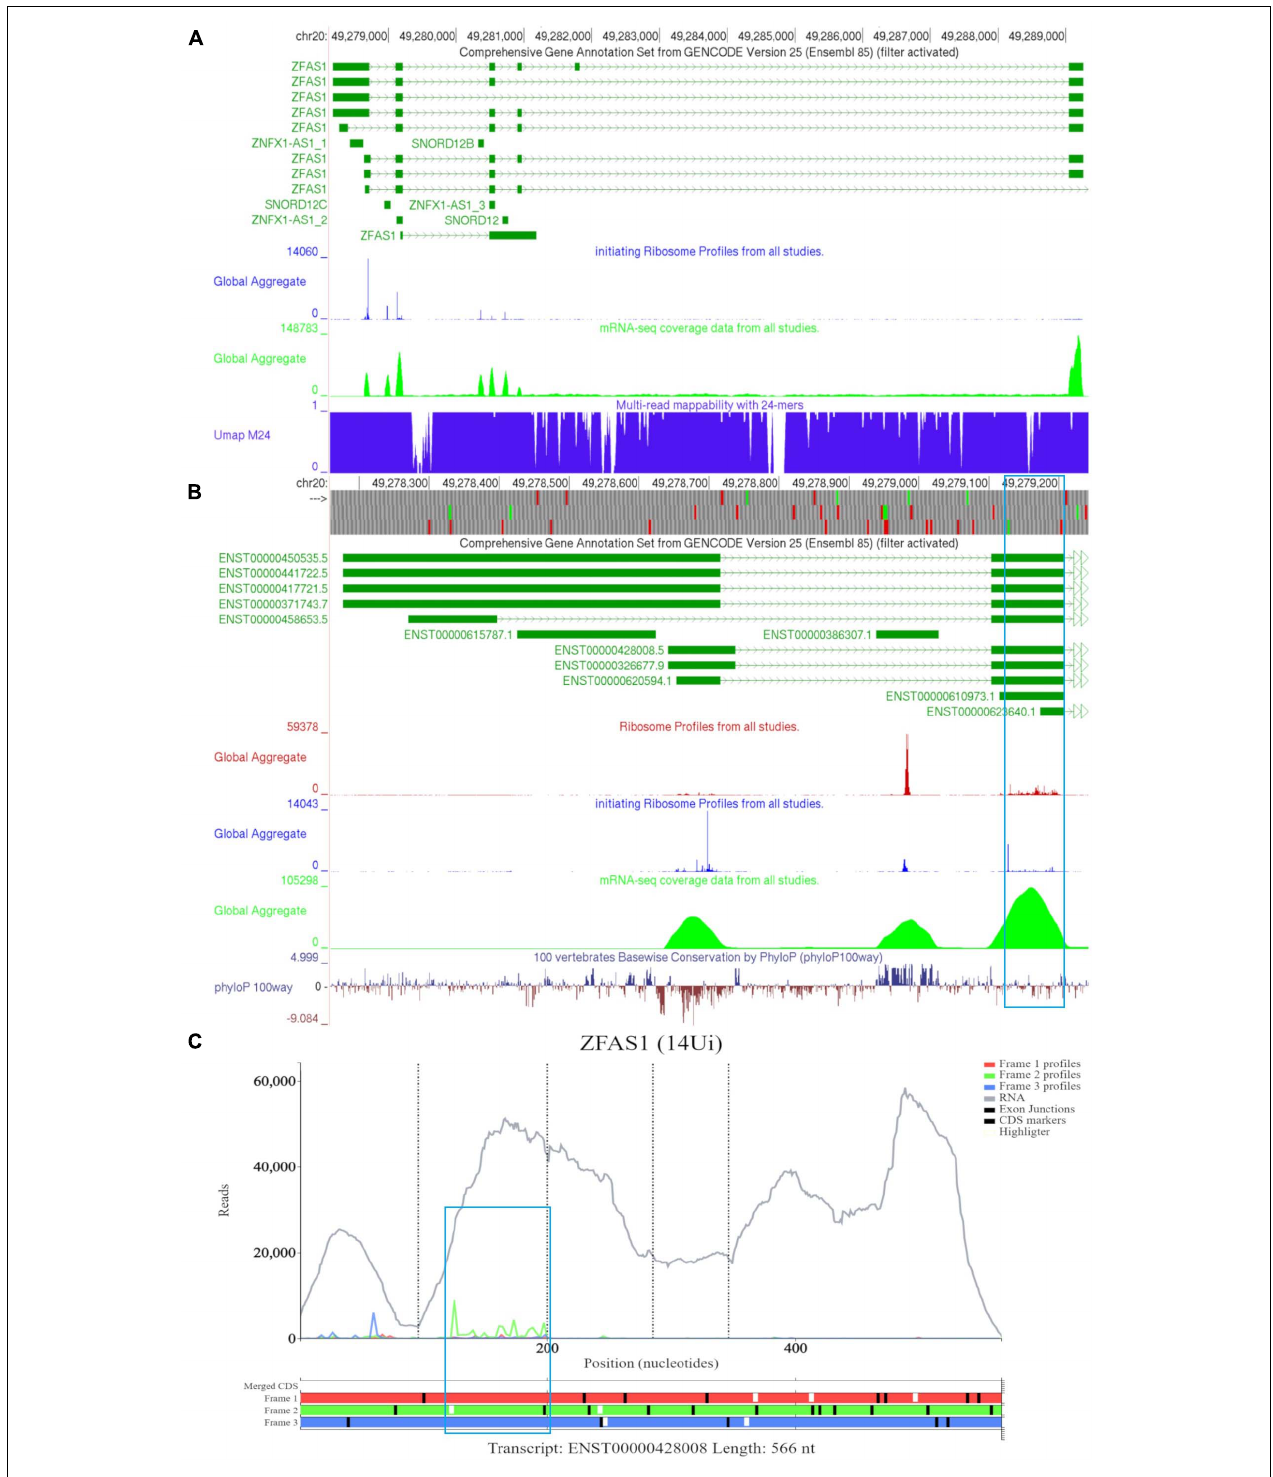
FIGURE 6 | Visualization of ZFAS1 in GWIPS-viz and Trips-Viz. (A) Whole transcript view of ZFAS1 in GWIPS-viz with the ‘Comprehensive Annotation Set from Gencode Version 25,’ ‘initiating Ribosome Profiles from all studies,’ ‘mRNA-seq coverage data from all studies’ and ‘Multi-read mappability with 24mers’ tracks enabled. (B) Visualization of the 5 (cid:48) end of ZFAS1 in GWIPS-viz with the tracks described in Section Setup and Configurations enabled. An ORF on the second exon of multiple ZFAS1 isoforms is outlined in blue. (C) Visualization of ZFAS1 isoform ENST00000428008 in Trips-viz. The ORF previously outlined in blue in GWIPS-viz is similarly outlined